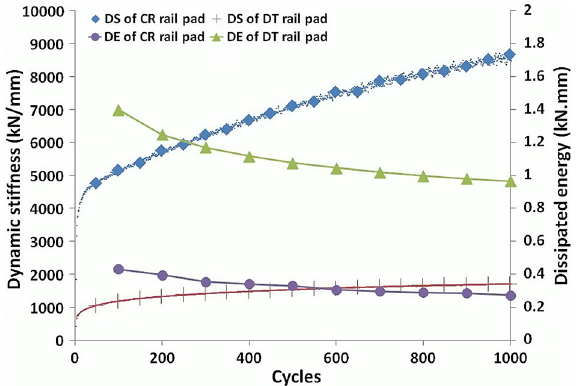
Fig. 7. Long-term analysis of dynamic stiffness (DS) and accumulated dissipated energy